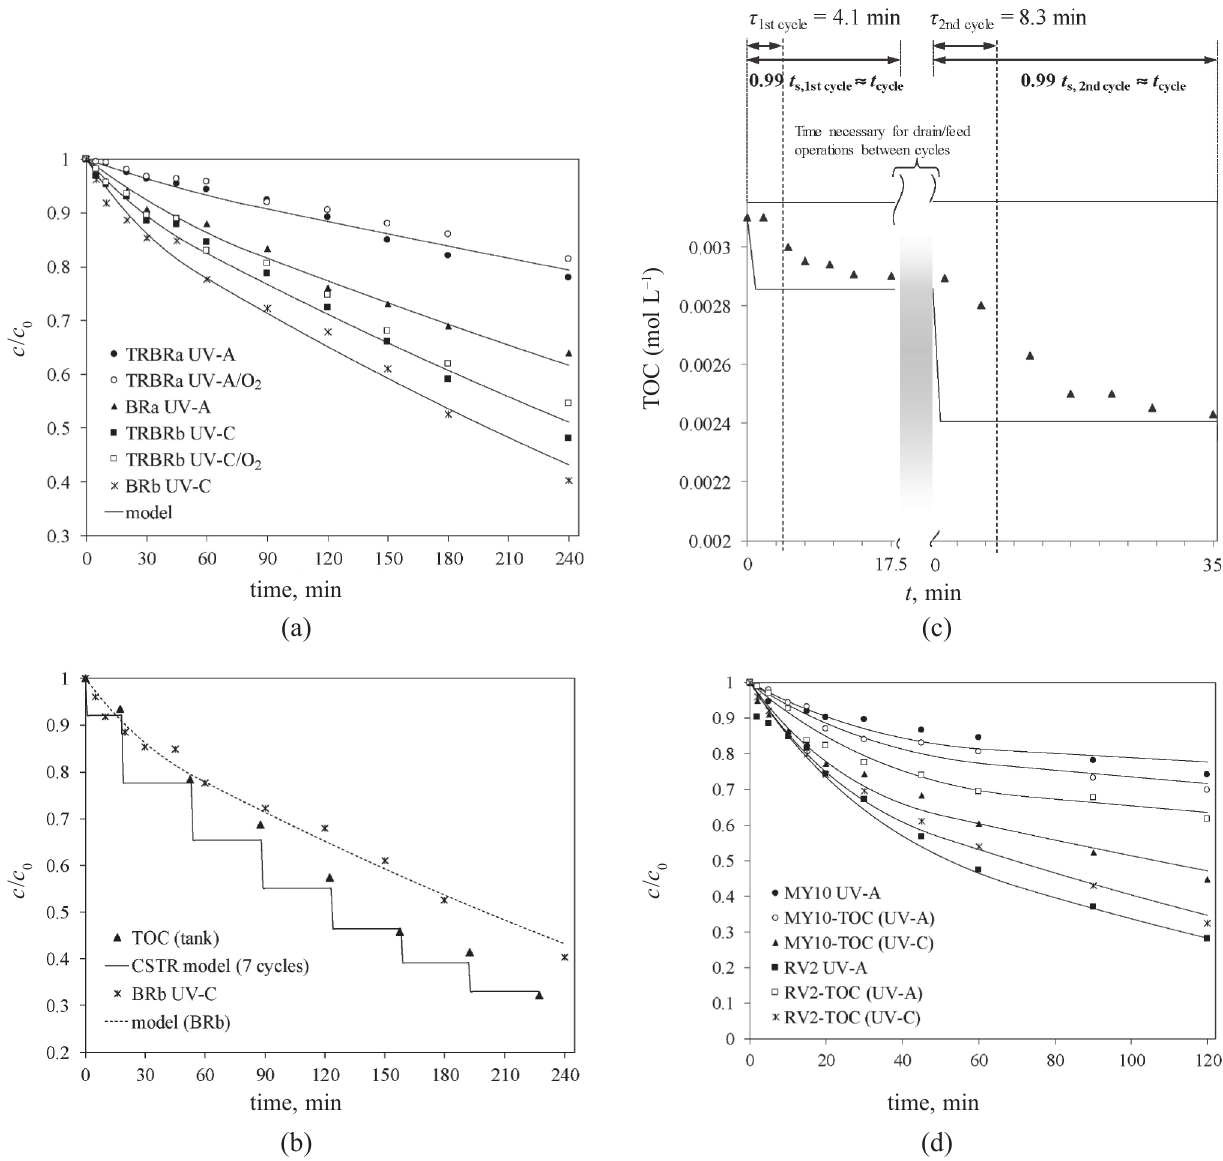
Fig. 2 – (a) DAW mineralization kinetics (pH ≈ 4, 0.4 g dm –3 TiO P25) in the cylindrical reactors operated in batch and total re - 2 circulation mode using UVA and UVC irradiation, (b) Comparison between the photocatalytic experiments in BRb and CSTR operat - ed in seven consecutive cycles (dots represent the concentration in the collecting tank after each cycle), (c) Comparison of idealized steady-state CSTR model (solid line) with the experimental TOC values as a consequence of CSTR start-up times in 1 st and 2 nd cycle, (d) Degradation of dyes and related mineralization in dye solutions (RV2 and